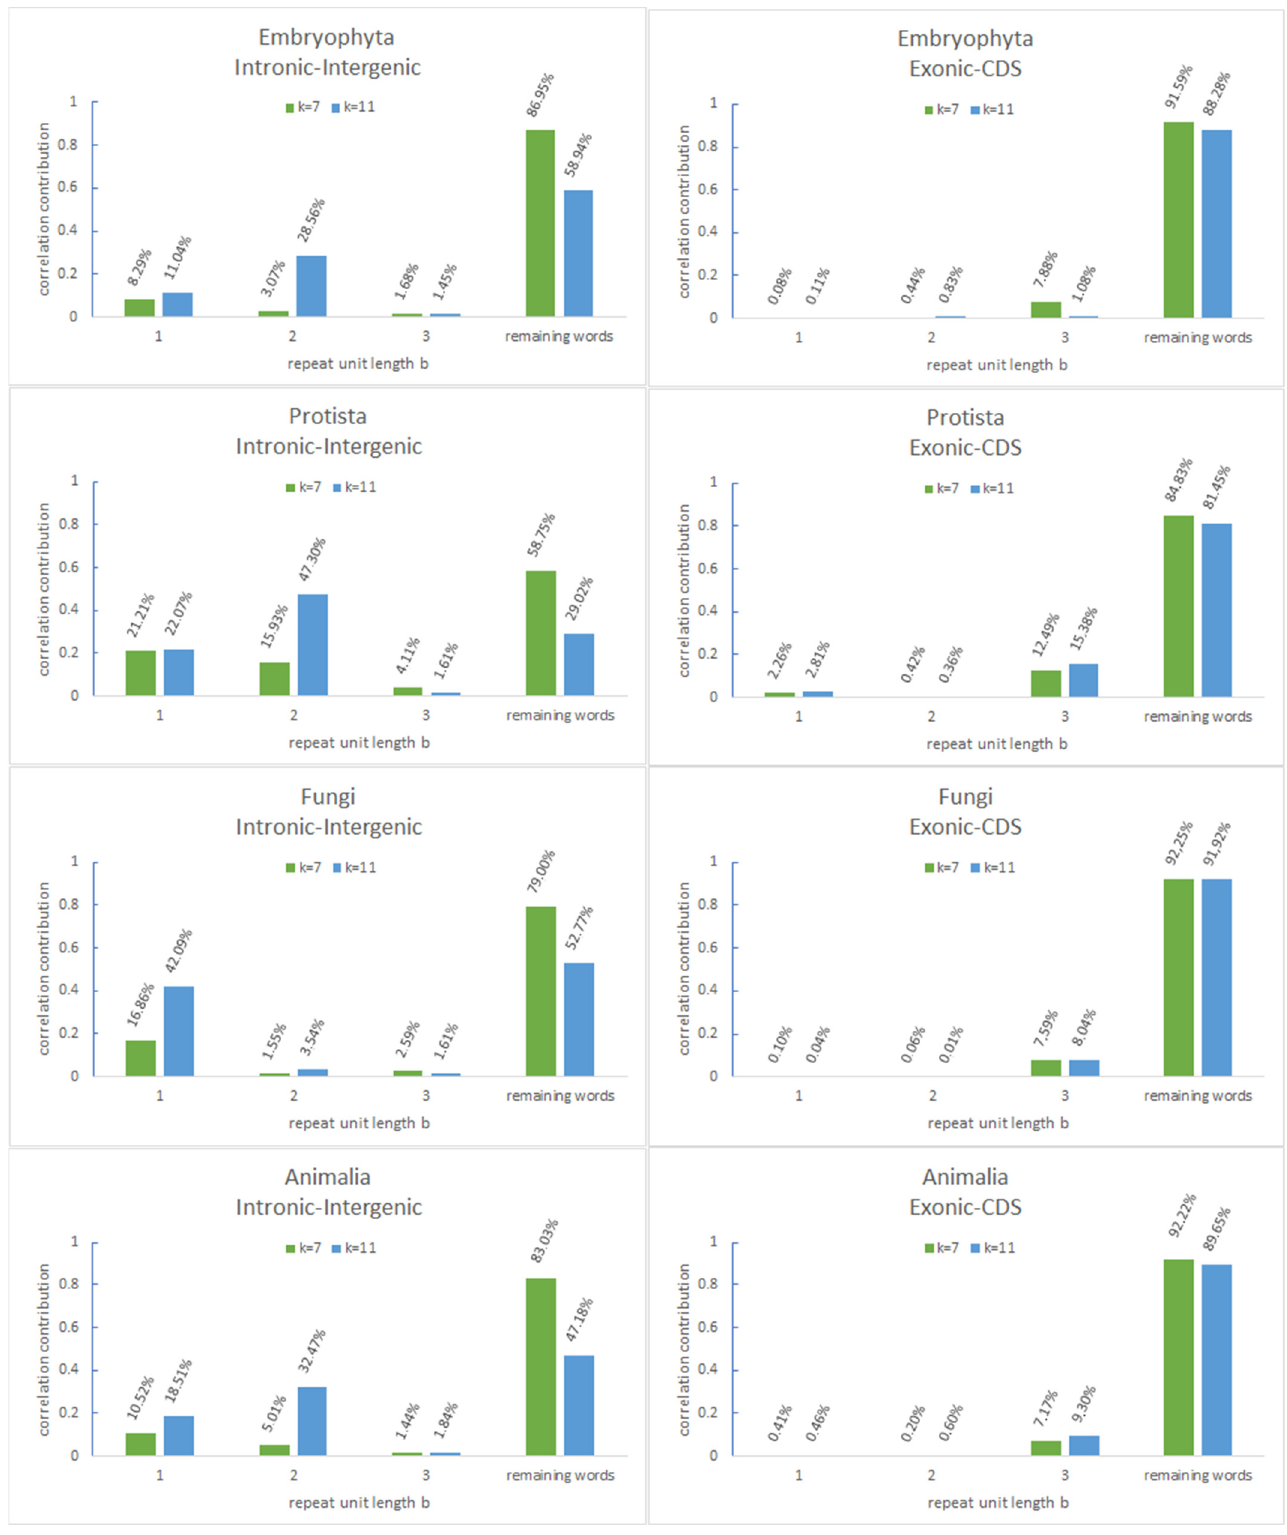
Figure 4. Correlation contribution of different repeat unit lengths ( b = 1 to b = 3) for Embryophyta , Protista , Fungi and Animalia . Histograms representing the correlation contributions of tandem repeat k -mer words for k = 7 and k = 11 for intergenic–intronic correlations and for exon–CDS correlations are shown. Table 2. Correlation contributions of tandem repeats words ( k = 7) for different chain seed lengths b (1 ≤ b ≤ 3). The correlation contributions for correlations between different genomic regions